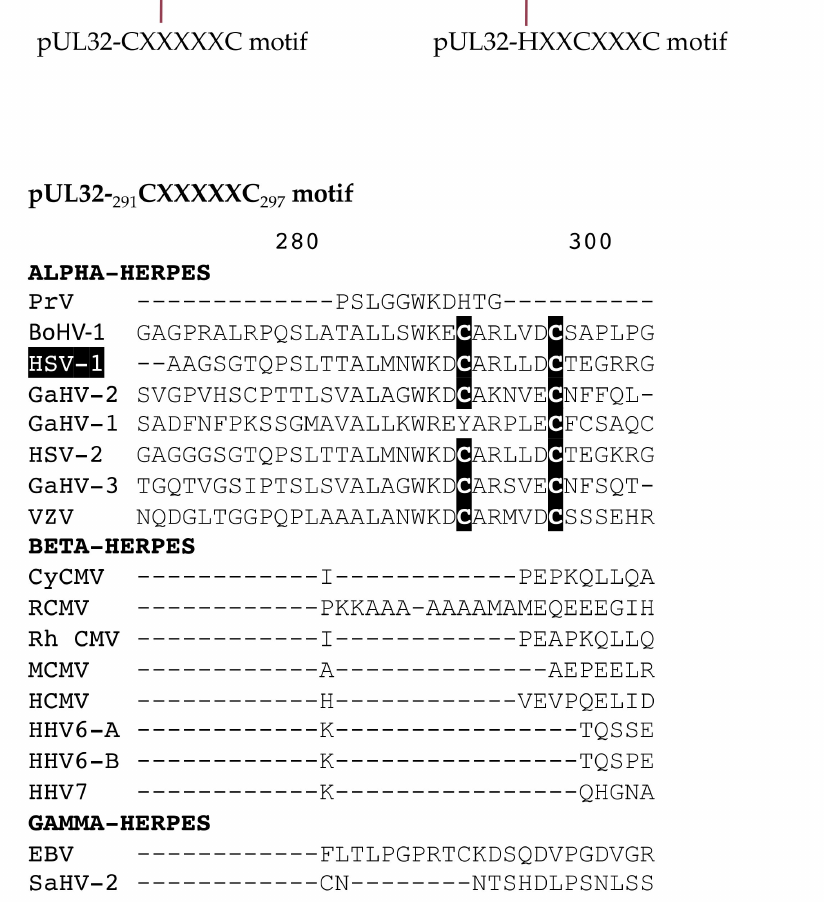
Figure 2. Distribution of the polymorphism through the HSV-1 pUL32 protein and motifs previously described by Albright in 2015. ( a ) pUL32 strains were identified through a sequence similarity search against pUL32 using the NCBI BLAST program. The 44 pUL32 HSV-1 strains were aligned using Clustal W alignment with Geneious 9.1.8 software. Each mutation is annotated as a saddle brown triangle. Motifs previously described are represented with a peach puff rectangle. ( b ) Sequence alignment from 18 herpesviruses of the pUL32- 291 CXXXXXC 297 motif. Sequence numbering is consistent with that of HSV-1 strain residues. Key residues involved in the CXXXXXC motif are shown as white letters on black background. VRI and VRII: variable regions I and II. aa: amino